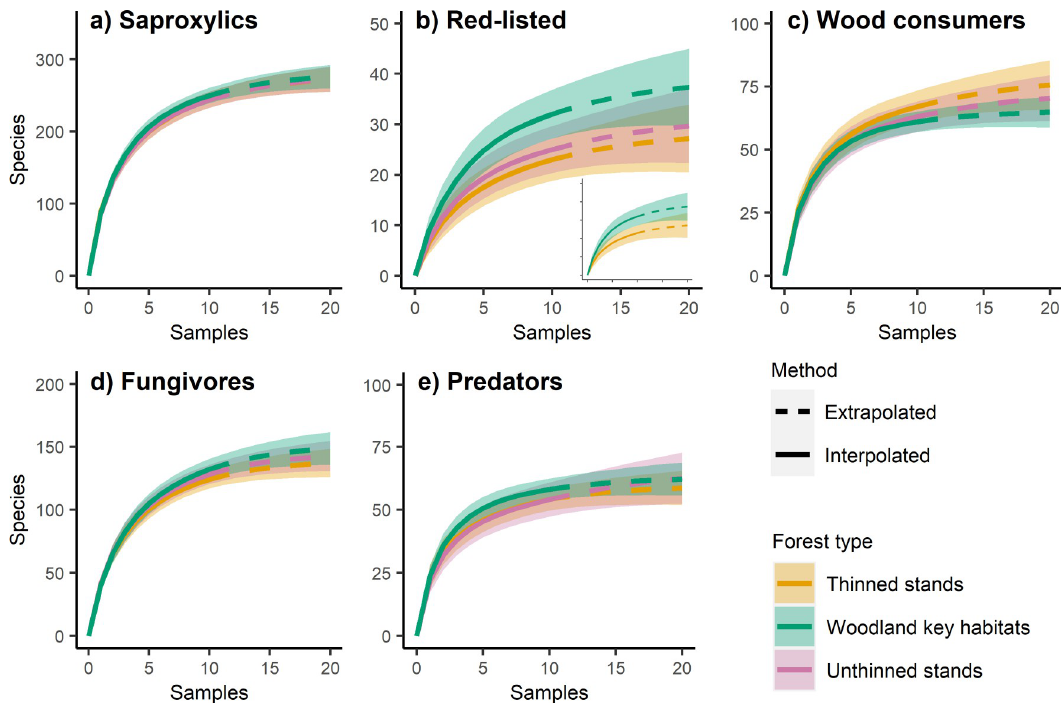
Fig 6. Gamma diversity O¨rebro. a-e) Species accumulation curves with 95% confidence intervals for each forest type and species group from the O¨rebro sample. Samples are forest stands (data from two traps per stand pooled), extrapolated to twice the original sample size. In b), the inlay shows the curves for the Woodland Key Habitats and the thinned stands, with the unthinned stands removed for